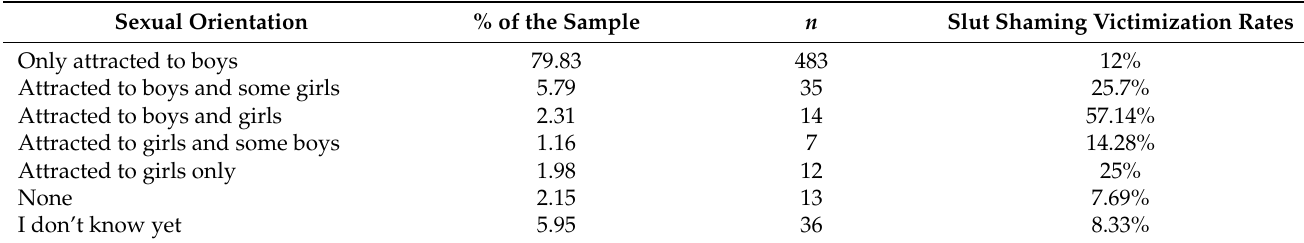
Table 1. Sexual orientation and slut shaming victimization rates.